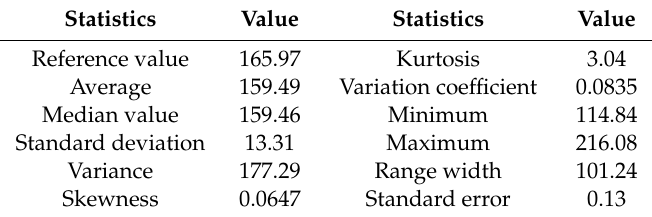
Figure 10. Probability distribution for commercial solar LCOE. Table 3. LCOE statistics for commercial solar energy generation.